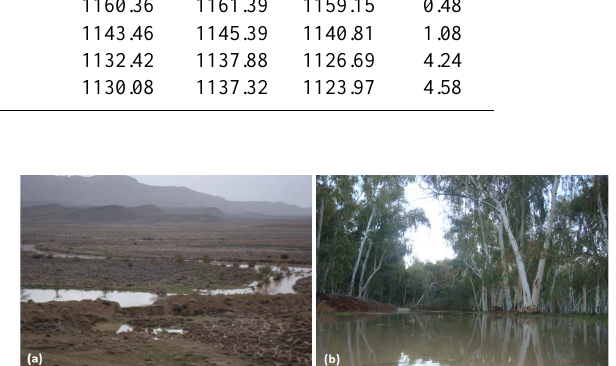
Fig. 11. Vegetation cover in: a) artificial recharge zone 2 (AR 2) and b) artificial recharge zone 1 (AR 1).